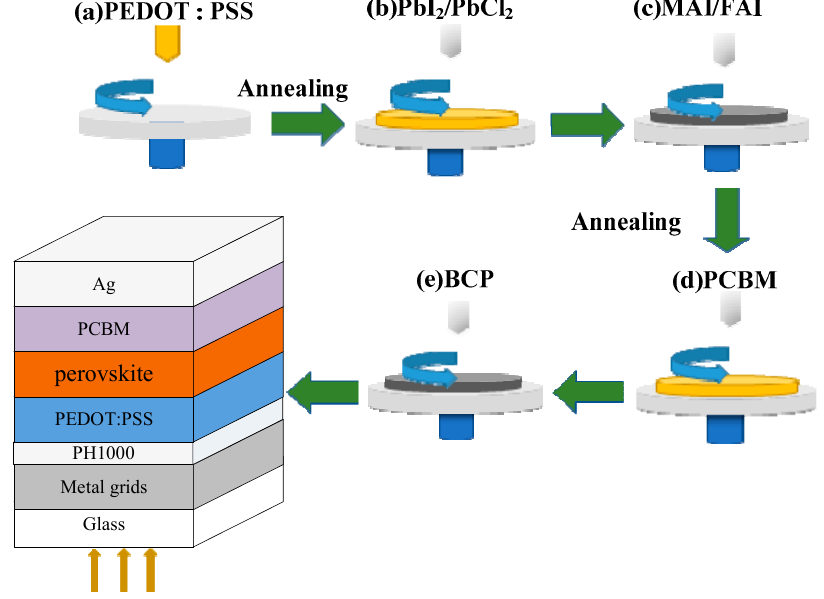
Figure 1. Process of indium thin oxide (ITO)-free perovskite solar cells (PSCs) based on a metal mesh transparent electrode.